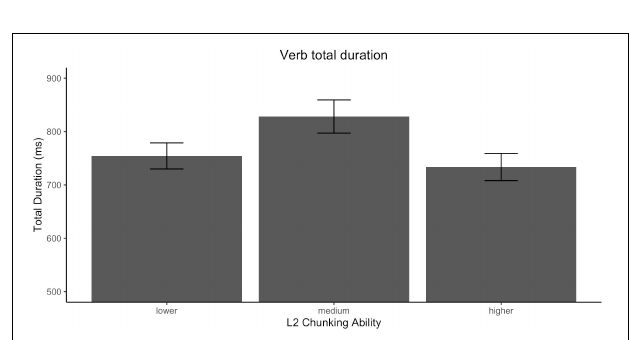
Chunk Sensitivity, L2 multiword knowledge and Congruency